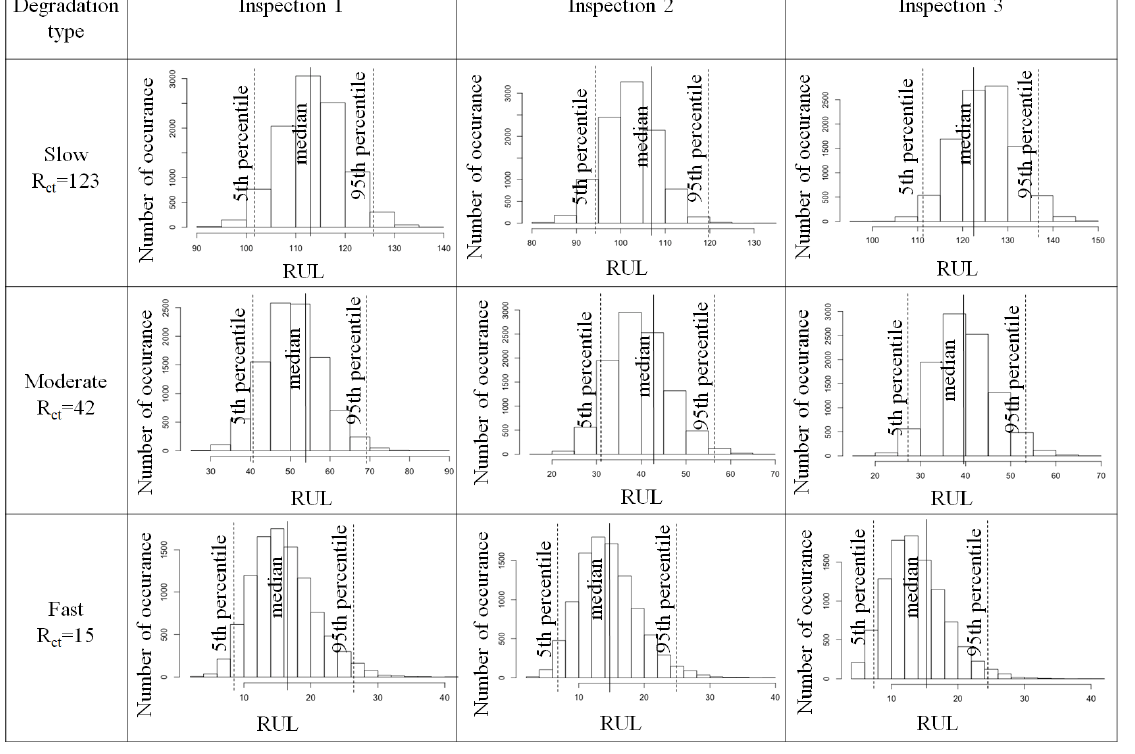
Figure 14. Position of the real crossing time R ct compared to the 5% and 95% percentiles of the RUL histograms for real data with the KNN algorithm at different inspection times: Slow, moderate, and